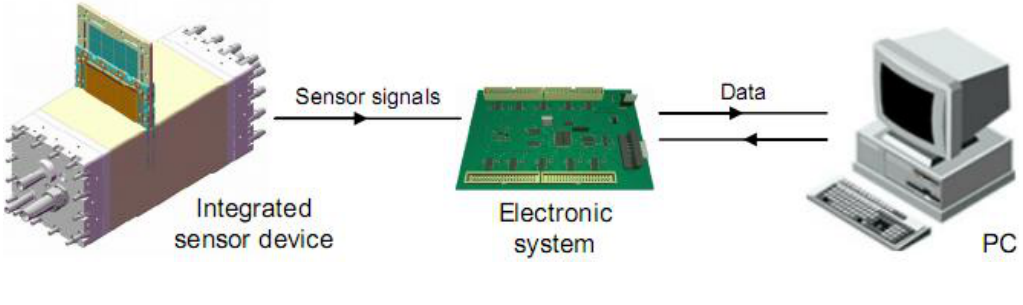
Figure 2. Schematic assembly of the measurement